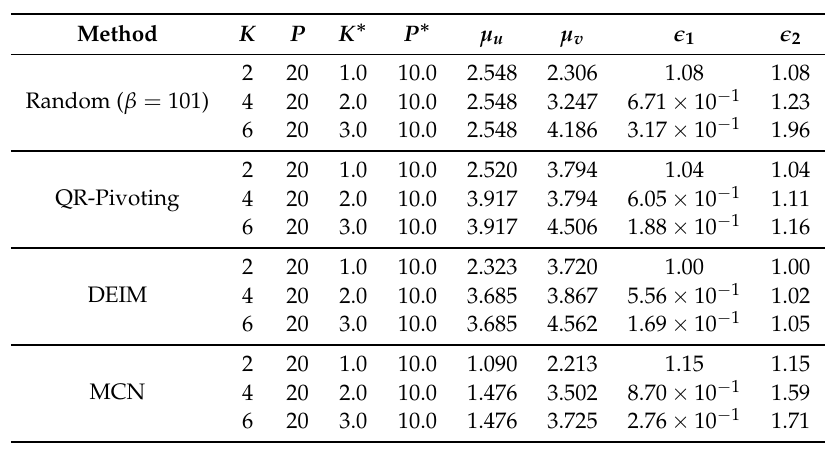
Table 3. Sparse reconstruction performance quantification for different sensor location selection method for periodic cylinder flows at Re = 100. (cid:101) 1 is the SR error normalized by the exact reconstruction error corresponding to a dimension of K 95 . (cid:101) 2 is the SR error normalized by the exact reconstruction error corresponding to a dimension of K